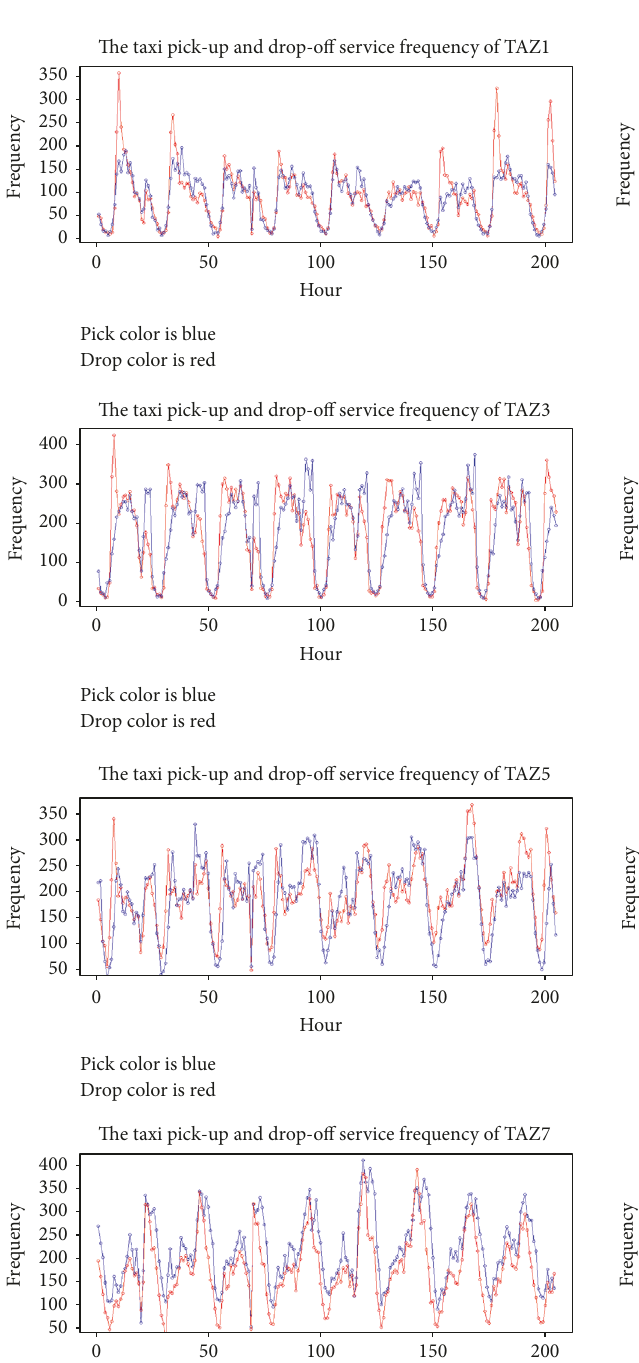
redPick color is blue Drop color is red Figure 4: Eight TAZs passenger pick-up (in blue line) and drop-off (in red line) service statistics.